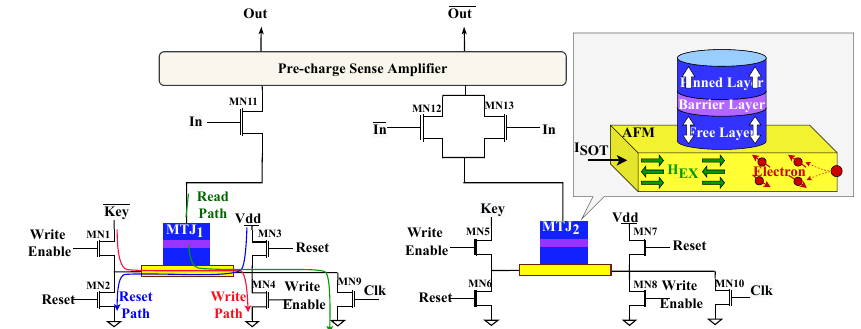
Figure 2. Logic-locking block schematic using VGSOT-MTJ.